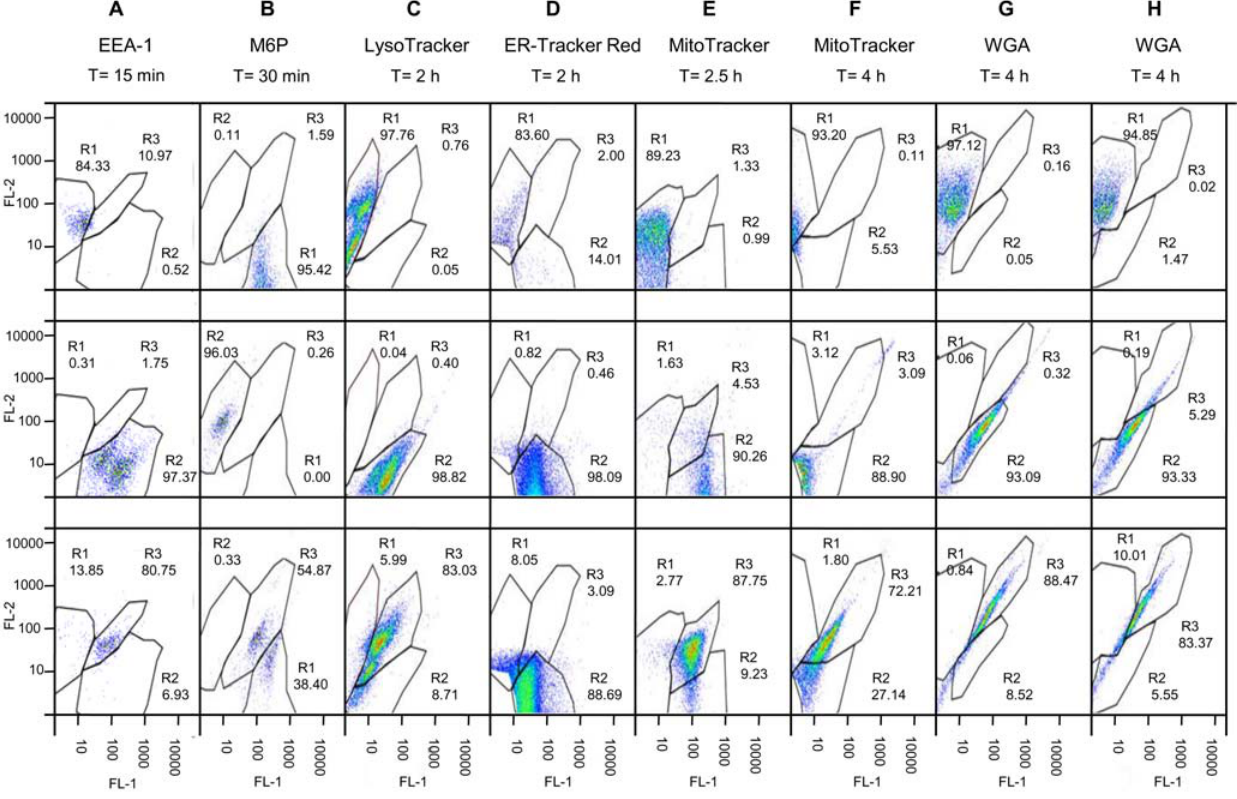
Figure 4. Trafficking of V as detected by flow cytometry. M F s were infected with either CO92 pPst- pgm- (panels A–E, G) or Y.pIII pIB604 (panel H); alternatively, LFnV (Panel F) was delivered with PA for different periods of time. Panel (A): M F s were infected for 15 min and stained with EEA-1 and anti-V Abs. Panel (B): M F s were infected for 30 min, stained with M6P and anti-V Abs. Panels (C and D): M F s were infected for 2 h followed by staining with LysoTracker or ER-Tracker Red, respectively, and anti-V Ab. Panel (E): M F s were infected for 2.5 h, stained cells with MitoTracker, followed by anti-V Ab. Panel (F): M F s were exposed to LFnV for 4 h, stained with MitoTracker, followed by anti-V Ab. Panel (G and H): M F s were stained for 30 min with WGA, infected for 4 h, and stained with anti-V Ab. Co-localization was defined by a population shift to region